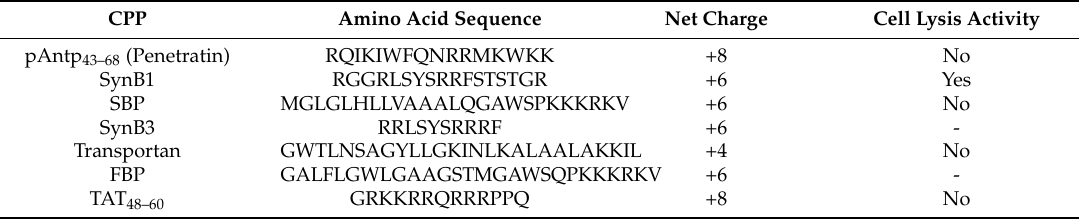
Table 1. Features of some naturally-occurring cell-penetrating peptides